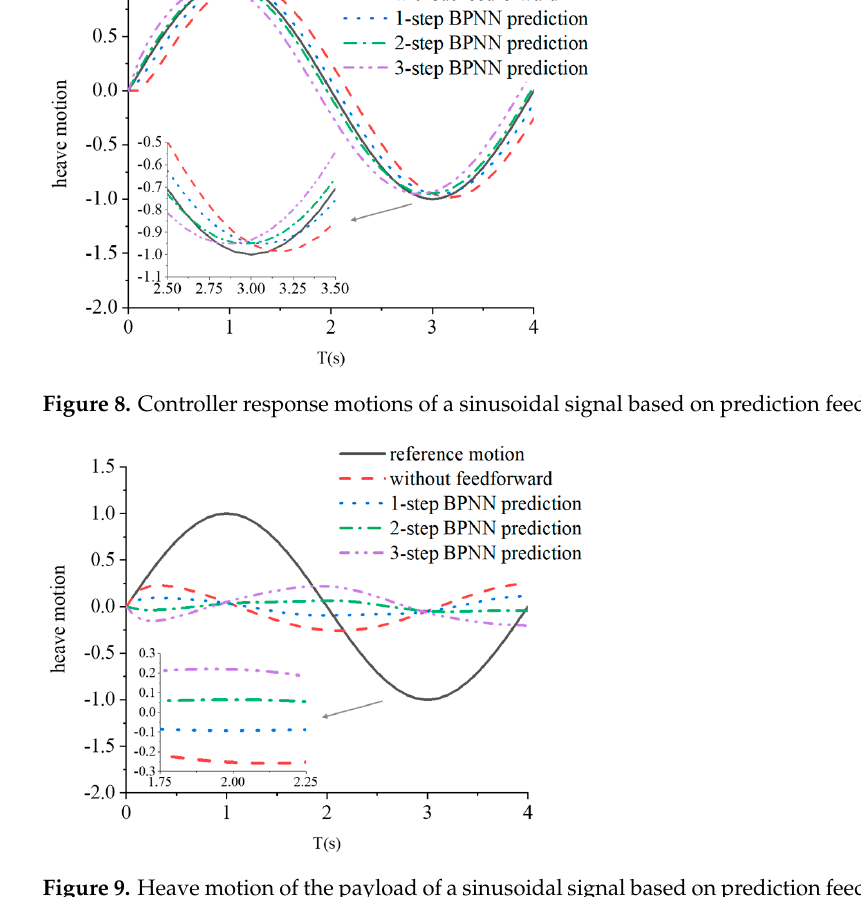
Figure 9. Heave motion of the payload of a sinusoidal signal based on prediction feedforward control. Table 1. Comparison of deviations based on actual data and prediction.